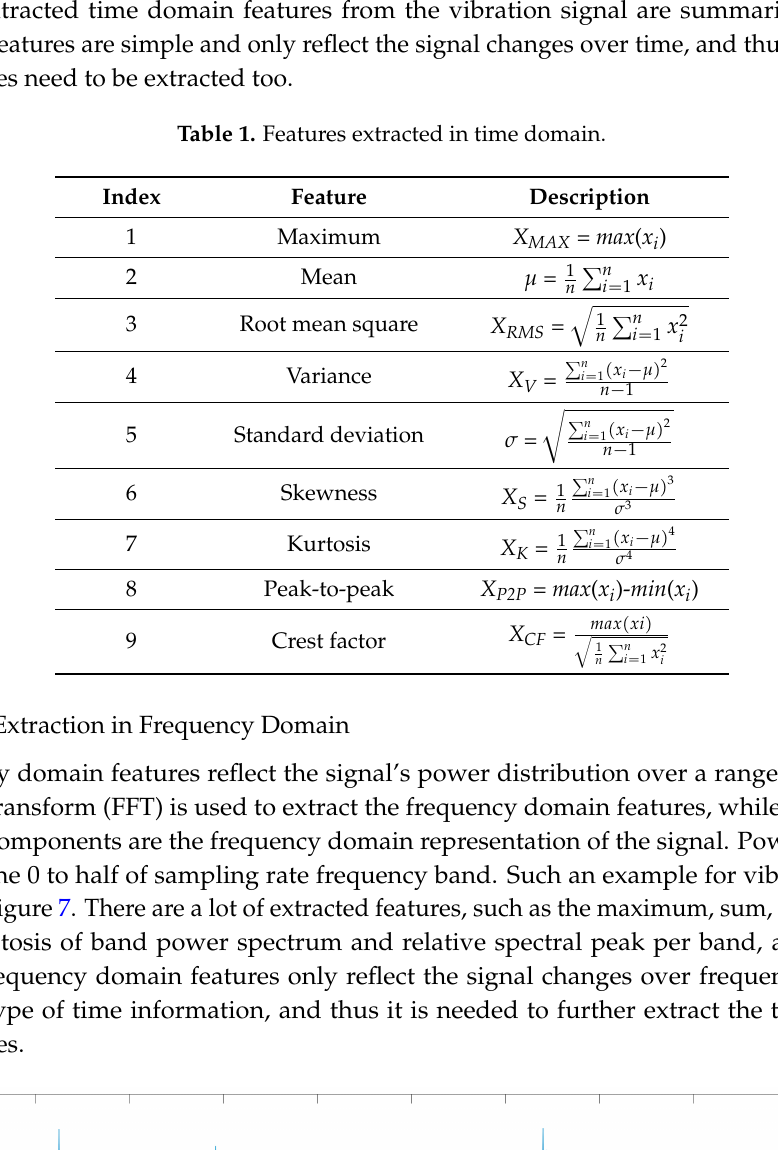
Table 1. Features extracted in time domain.